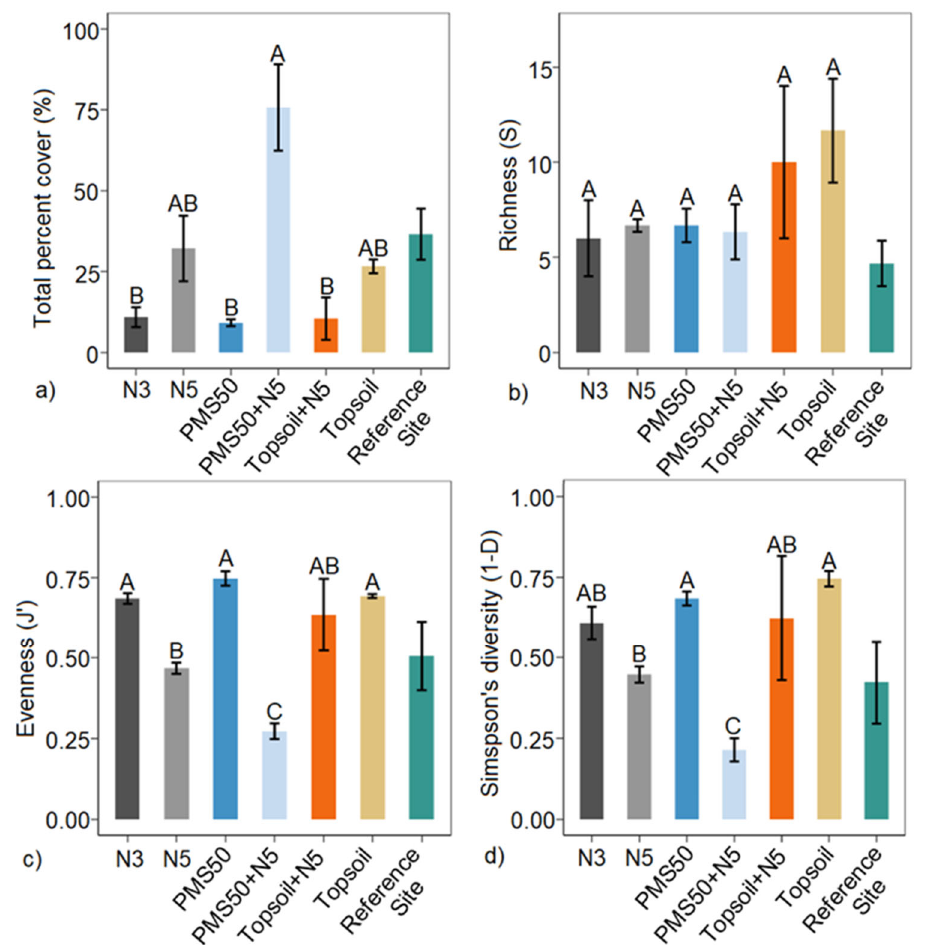
Figure 4. Mean ( a ) total percent cover, ( b ) richness (S), ( c ) Pielou’s evenness (J ′ ), and ( d ) Simpson’s diversity (1 − D) in relation to reclamation treatments (PMS50, PMS50+N5, topsoil, topsoil+N5, N3, and N5) ( ± SE; n = 3) at the Mont-Wright site. Letters represent statistical differences between treatments following post hoc tests, and brackets on each bar correspond to the standard error. The reference site was not included in the statistical model.